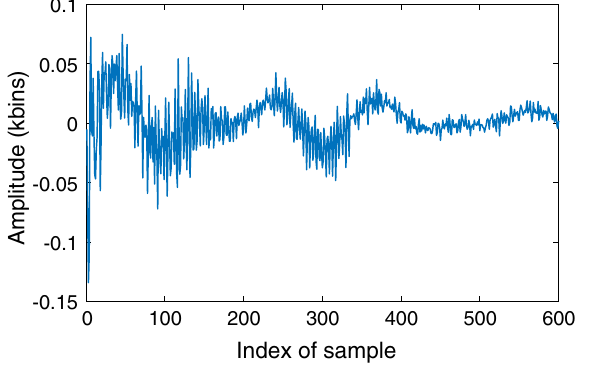
FIG. 9. Signal noise estimated by SVD with an RMS of 0.021 kbins, about 2% of the